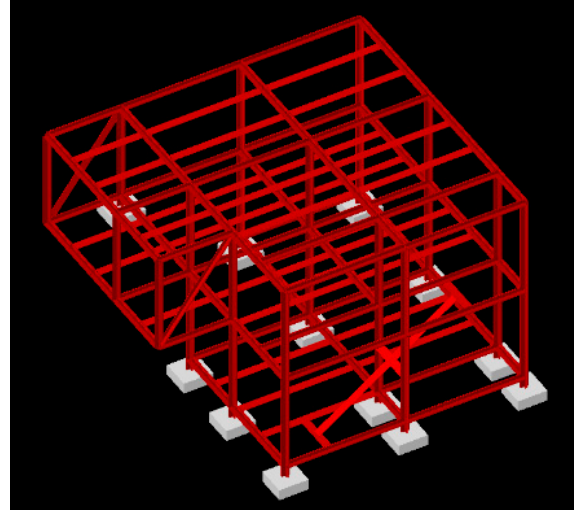
Figure 9. Rendering of the structural model used to check the structure.